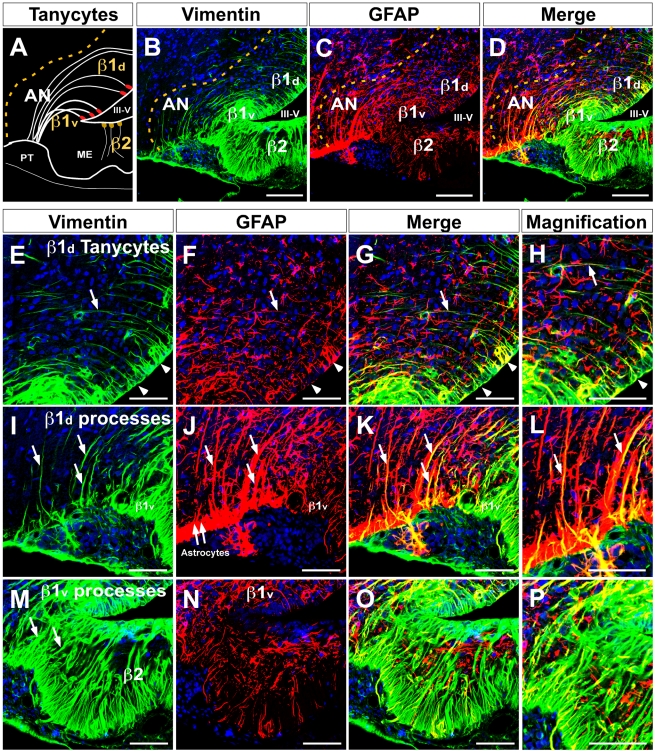
Dorsal and ventral β1-tanycytes distribution in the basal hypothalamus.
A, Schematic representation of the hypothalamic basal area showing dorsal and ventral β1-tanycytes. B, Low magnification of the basal hypothalamic area using anti-vimentin antibodies (green) and the TOPRO nuclear stain (blue). C, Low magnification using anti-GFAP antibodies (red) and the TOPRO nuclear stain (blue). D, Differential distribution of vimentin and GFAP in dorsal and ventral β1-tanycytes. E–L, Dorsal β1-tanycytes (β1d) showed reduced vimentin staining. The reaction was concentrated in the ventricular area (E, head arrows), which was also positive for GFAP (F–H). The processes of these cells were strongly positive for GFAP (J–L, arrows). M–P, Ventral β1-tanycytes (β1v) showed intense immunoreaction for vimentin (M) and very low staining with anti-GFAP (N–P). AN, arcuate nucleus, III-V: third ventricle, ME: median eminence. Scale bar: B–D, 150 µm; E–G, I–K and M–O, 50 µm; H, L and P, 25 µm.